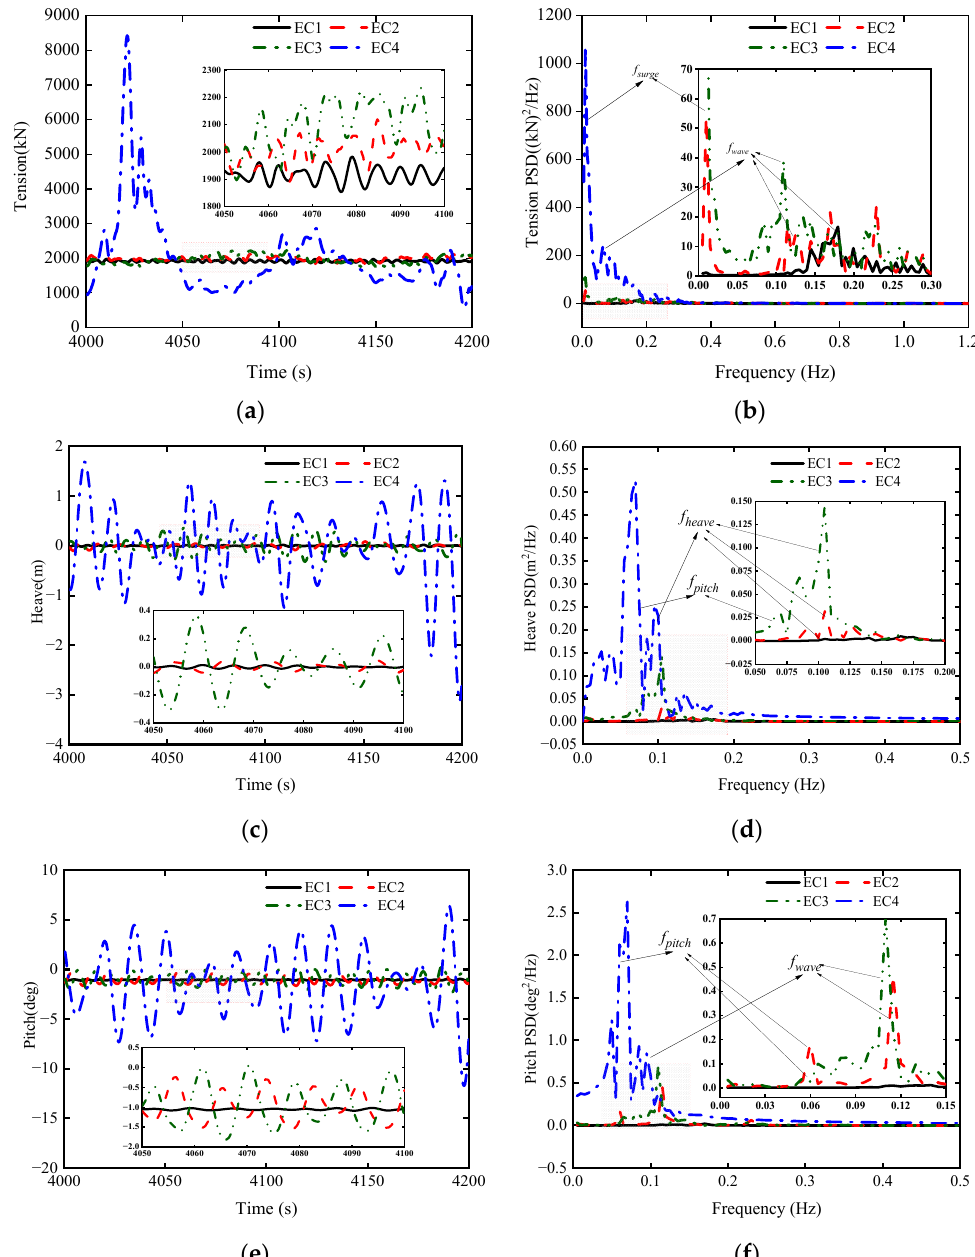
Figure 10. Time histories and spectra of the platform surge, heave and pitch motions: ( a ) Time histories of the surge ; ( b ) Spectra of the surge ; ( c ) Time histories of the heave ; ( d ) Spectra of the heave ; ( e ) Time histories of the pitch ; ( f ) Spectra of the pitch .